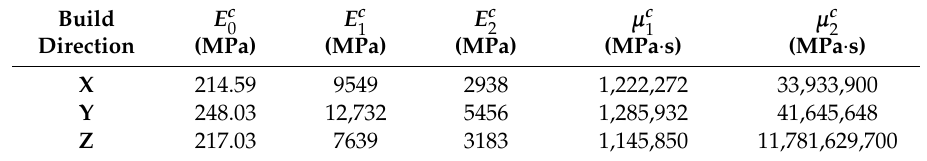
Table 5. Elastic moduli and dynamic viscosities obtained for the Kelvin–Voight model (Figure